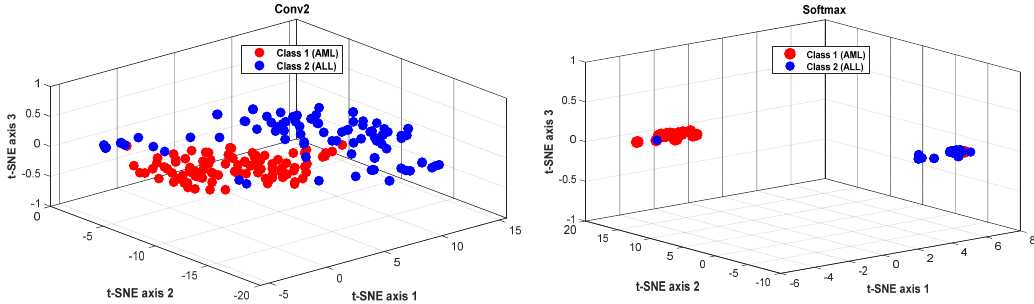
Figure 6. The visualization of the extracted features from the second layer of convolution, and the softmax layer for the testing data, using the t-SNE method.